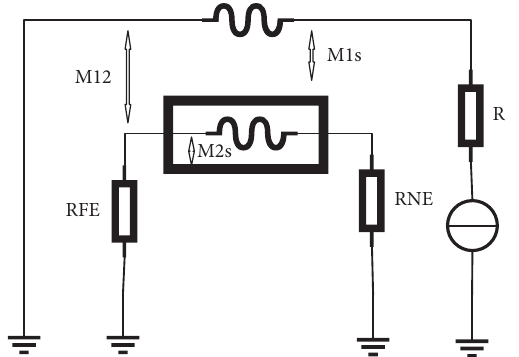
Figure 3: Schematic diagram of magnetic field passive shielding.